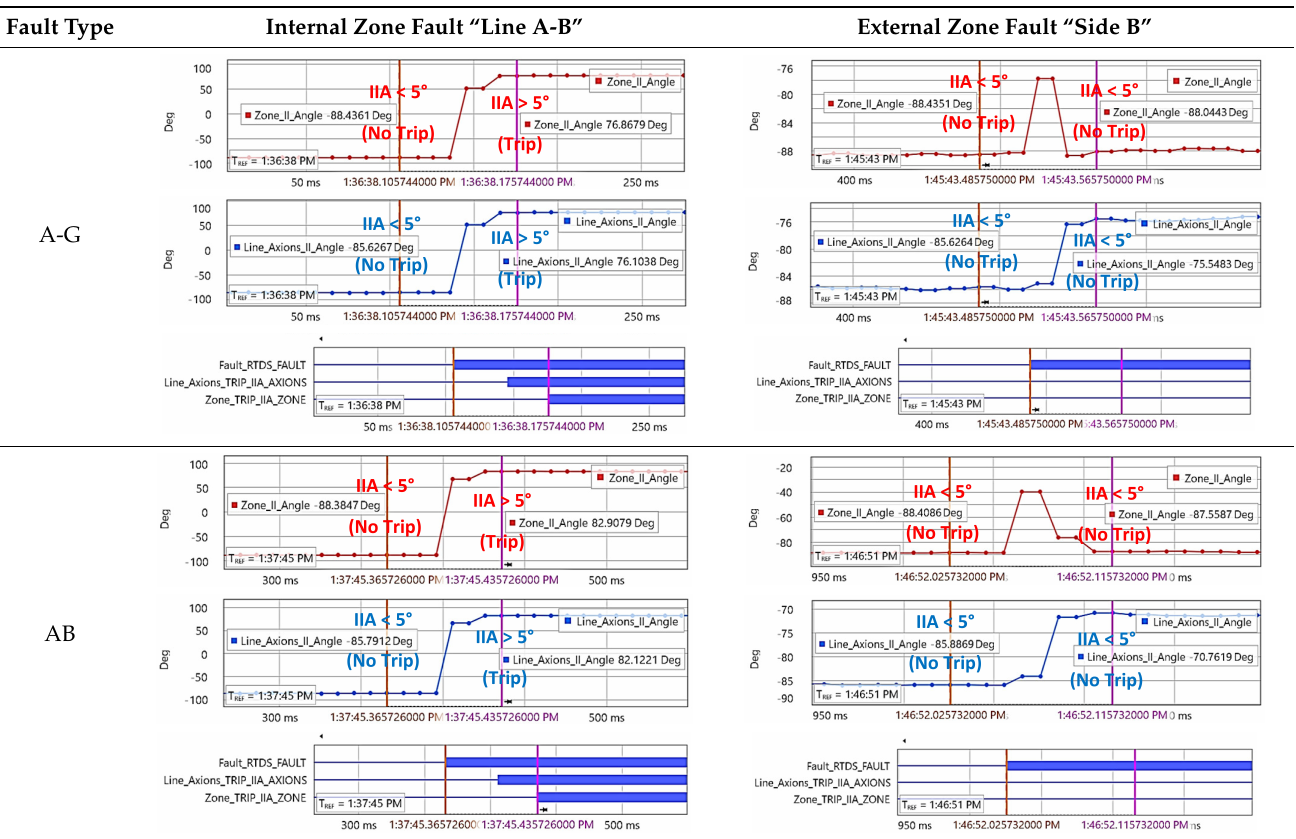
Table 8. IIA Zone behaviour with RES (Part 1 of